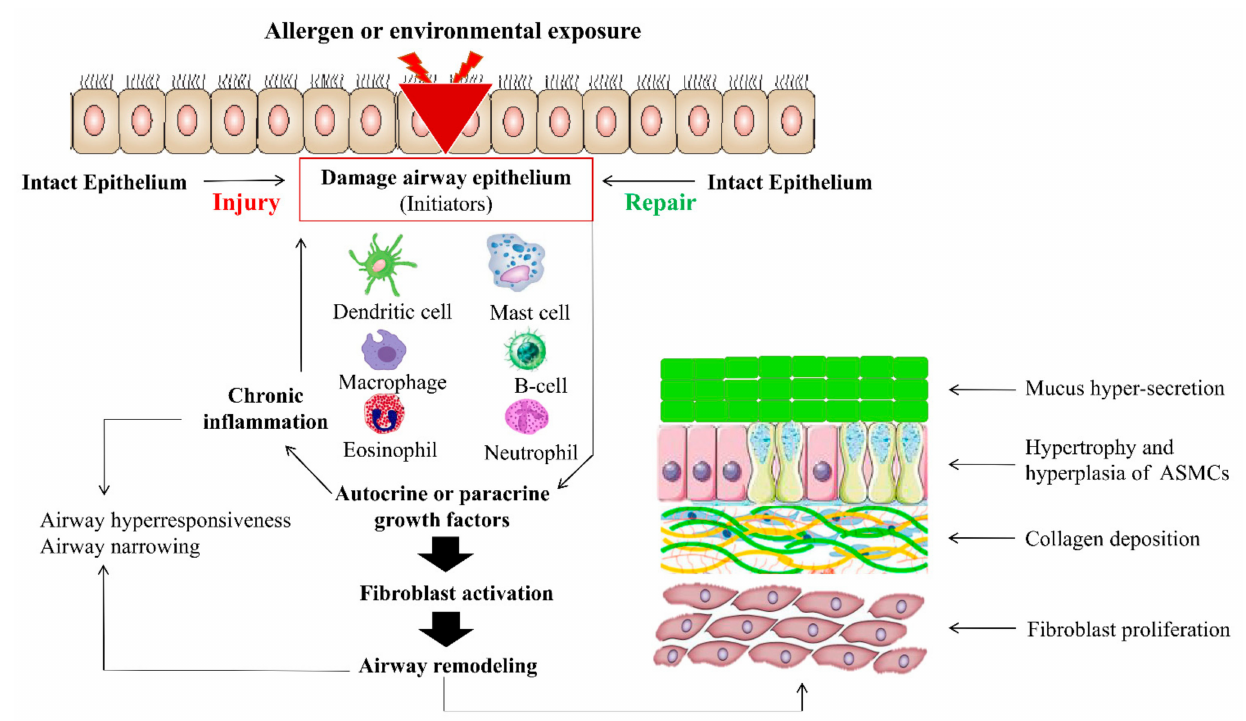
Figure 2. Airway remodeling. Allergens or environmental exposure damage the airway epithelium, which leads to activation of immune cells through releasing soluble factors. Airway epithelial and inflammatory cells contribute to the production of autocrine and paracrine factors that induce the proliferation, expansion, and activation of airway smooth cells, which ultimately initiate the morphogenesis in the lung development. Consequently, they produce a suitable environment for sustaining the chronic inflammation that causes the airway